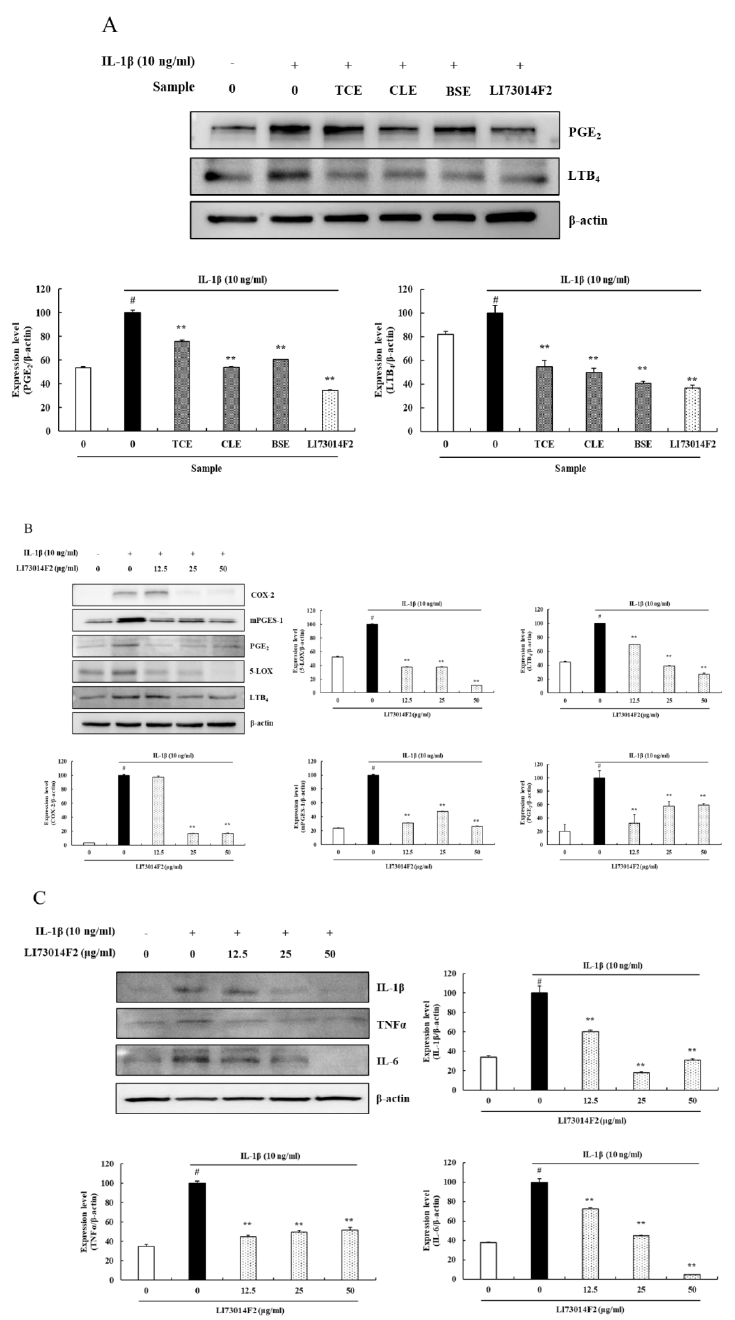
Figure 2. E ff ect of LI73014F2 on the expression levels of COX-2, mPGES-1, PGE 2 , 5-LOX, LTB 4 , IL-1 β , TNF α and IL-6 in IL-1 β -stimulated HCH cells. HCH cells were treated with IL-1 β (10 ng / mL) alone or in combination with extracts of T. chebula fruit (TCE) or extracts of C. longa rhizome (CLE) or extracts of B. serrata (BSE) or LI73014F2 for 24 h. ( A ). Effects of LI73014F2 on the expression of PGE 2 (42 kDa) and LTB 4 (36 kDa) compared with those of its individual extracts. ( B ) Effects of LI73014F2 on the expression of COX-2 (74 kDa), mPGES-1 (17 kDa), PGE 2 , 5-LOX (78 kDa) and LTB 4 in IL-1 β -stimulated HCH cells. ( C ) E ff ects of LI73014F2 on the expression of IL-1 β (17 kDa), TNF α (26 kDa) and IL-6 (25 kDa) in IL-1 β -stimulated HCH cells. Western blot bands were analyzed using Image J software. β -actin was used as a control for normalization. # P < 0.05, compared with the vehicle control group. * P < 0.05 and ** P < 0.01, compared with the IL-1 β -treated control